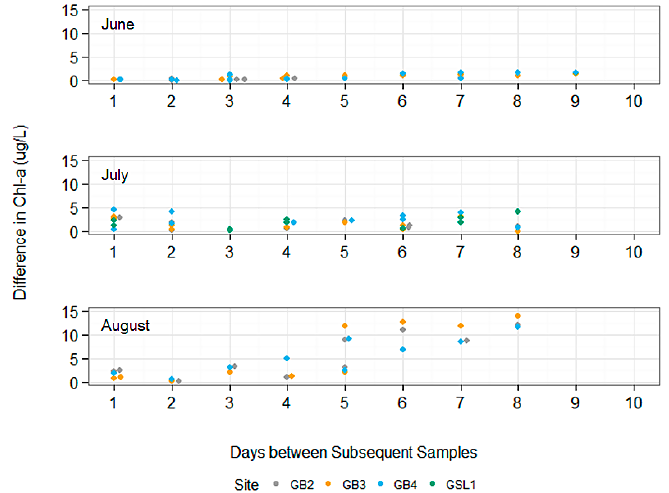
Figure 3. Temporal Variation between Subsequent Samples by Sampling Periods at the GB and GSL Sites.